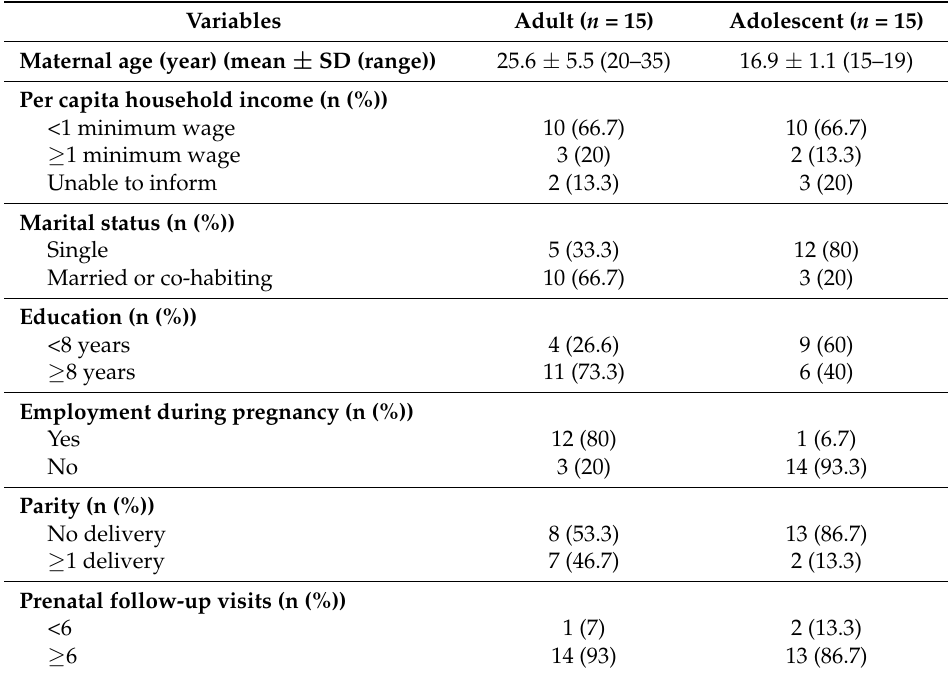
Table 2. General characteristics of the adult and adolescent mothers.